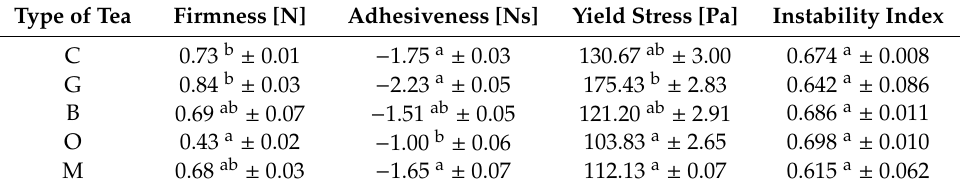
Table 1. Physical properties of tea infused yoghurts. C—Control, G—Green tea, B—Black tea, O—Oolong tea, M—Lemon